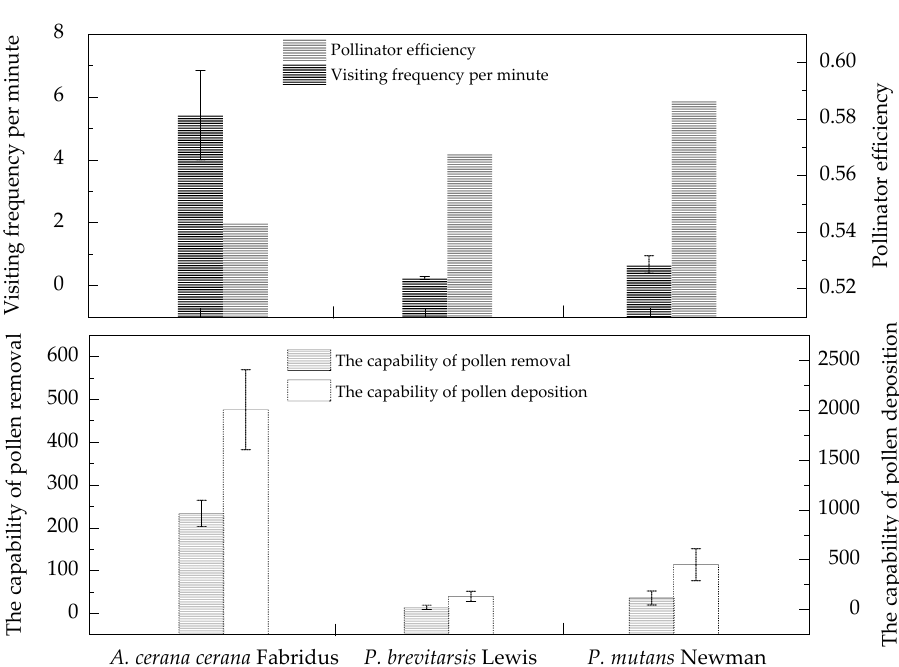
Figure 7. The general visiting frequency, pollinator efficiency, capability of pollen removal and deposition for three pollinators after the first visitation of a Schima superba flower (S.E.)